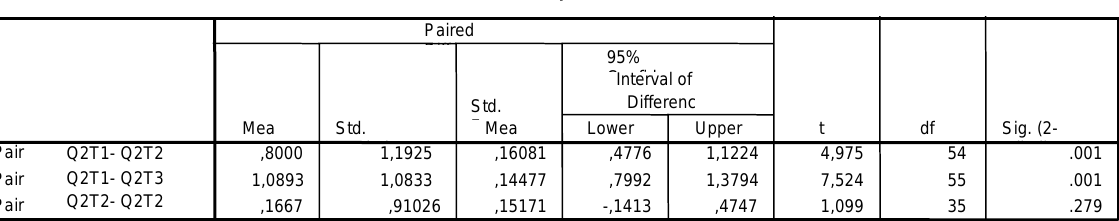
Self-Assessed Mental Health Significantly Improved with Clinical Holistic Medicine Paired